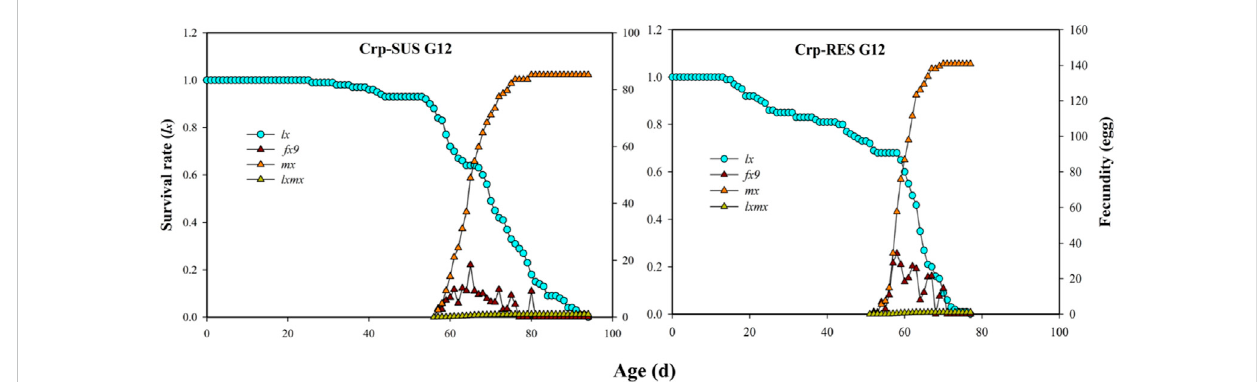
FIGURE 4 Age-speci fi c survival rate ( l x ), female age-speci fi c fecundity ( f x9 ), age-speci fi c fecundity of the total population ( m x ), and age-speci fi c net maternity ( l